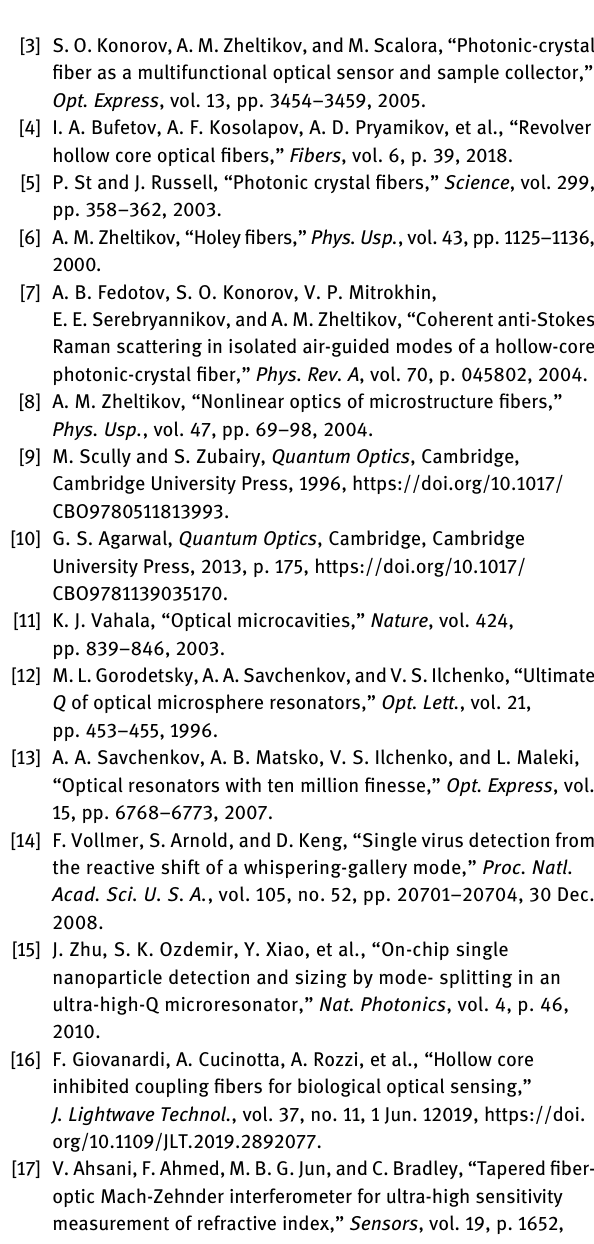
Figure 9: Normal mode frequencies (a) and their decay rates Γ (b) as a function of the angular quantum number m for the radial quantum number l = 1, 2, 3, 4, and 5, obtained by numerical solution of Eq. (13) with n